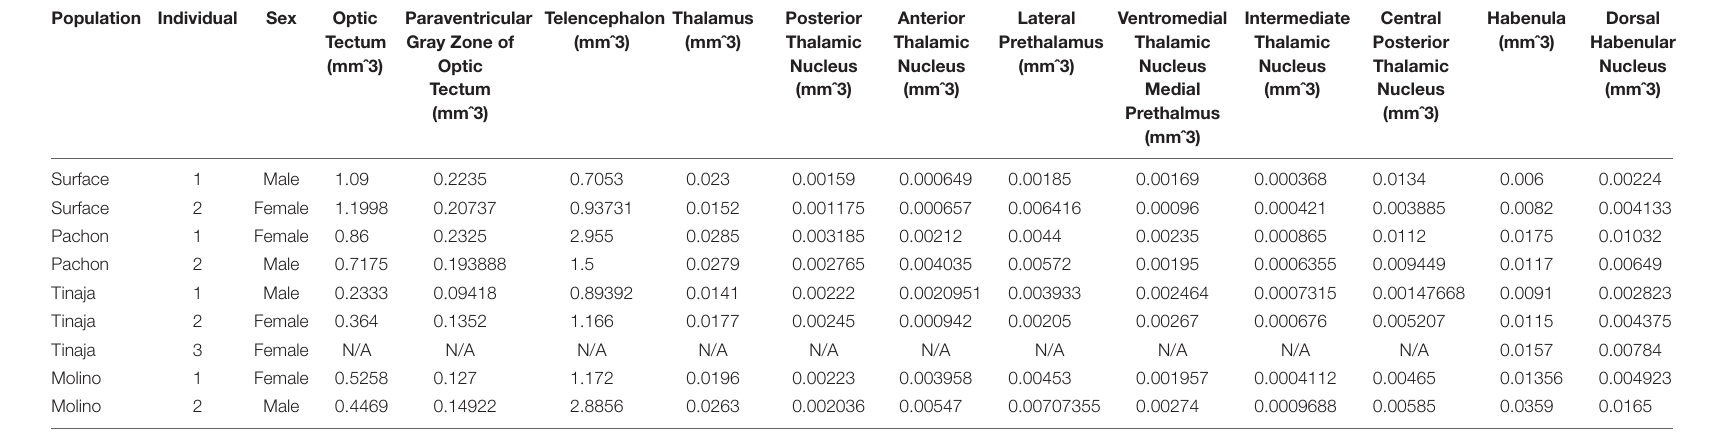
TABLE 2 | Raw Data of neuroanatomical loci. Population